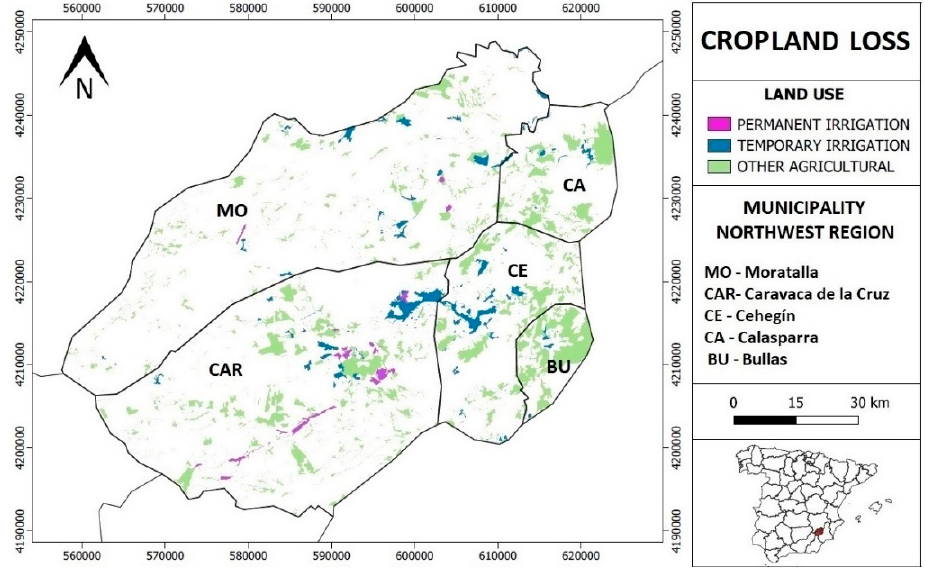
Figure 11. Loss of cultivated area as a function of agricultural use (1990–2018). Source: Authors.